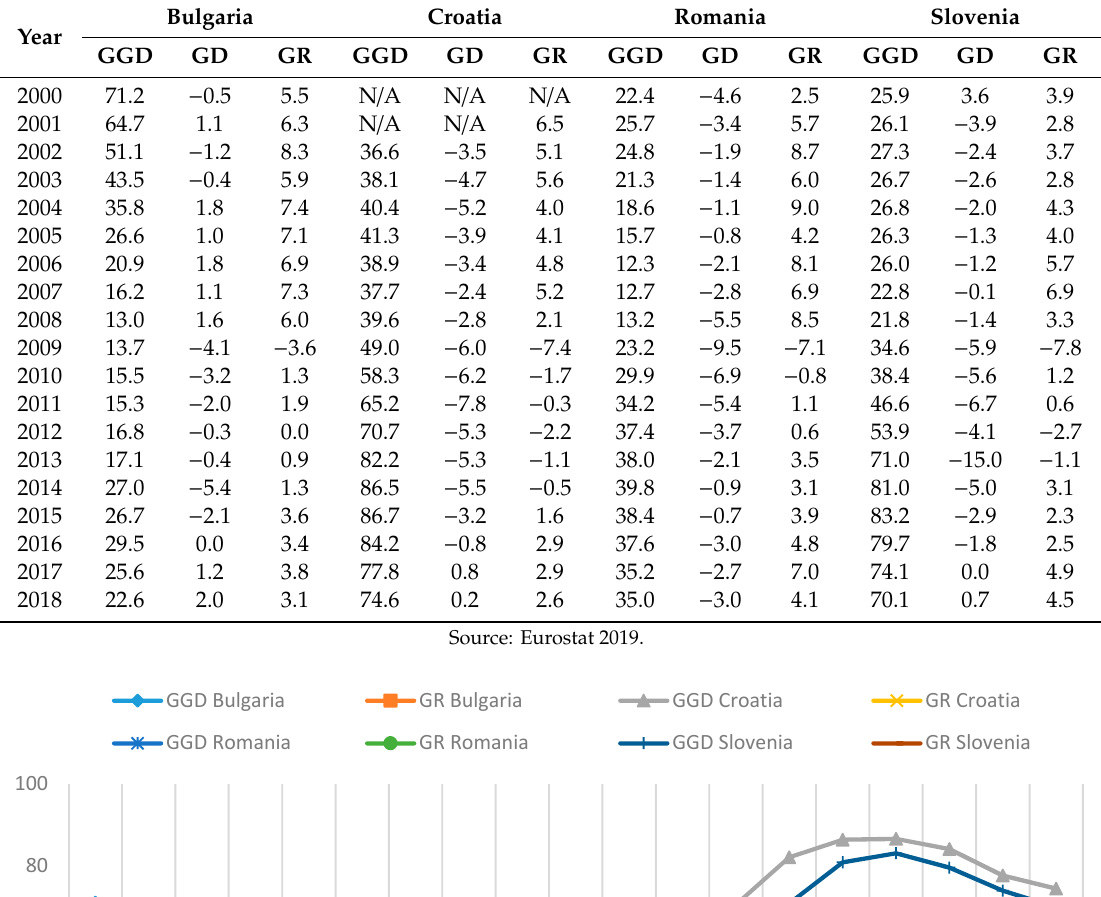
Table 3. The Balkan countries’ GGD percentage of GDP, GD percentage of GDP, and growth rate percentage change from previous year, 2000–2018.